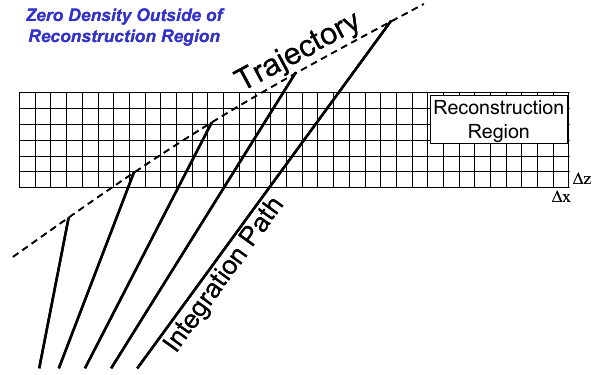
Figure 10. Solution grid for thin layer tomography.